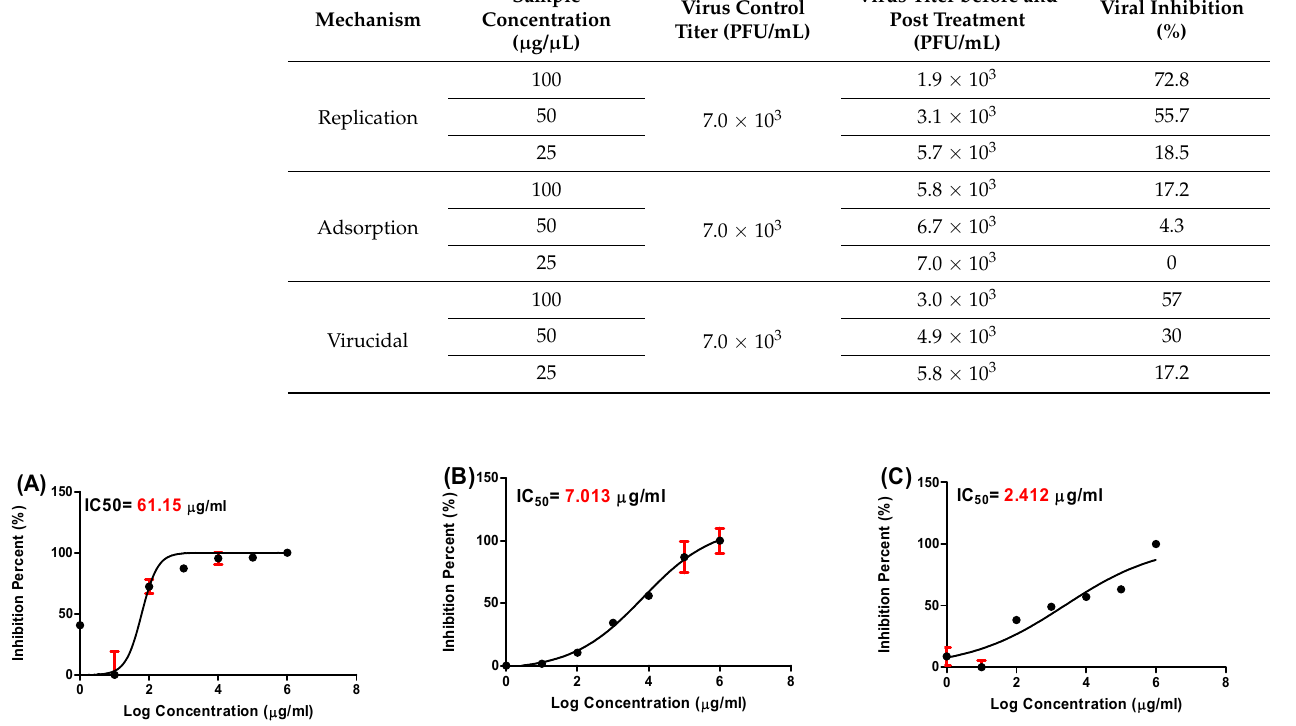
Table 5. (DG, interactions) kcal/mol of (natural tested ligands) against the target site of (HCo-V 229E main protease).